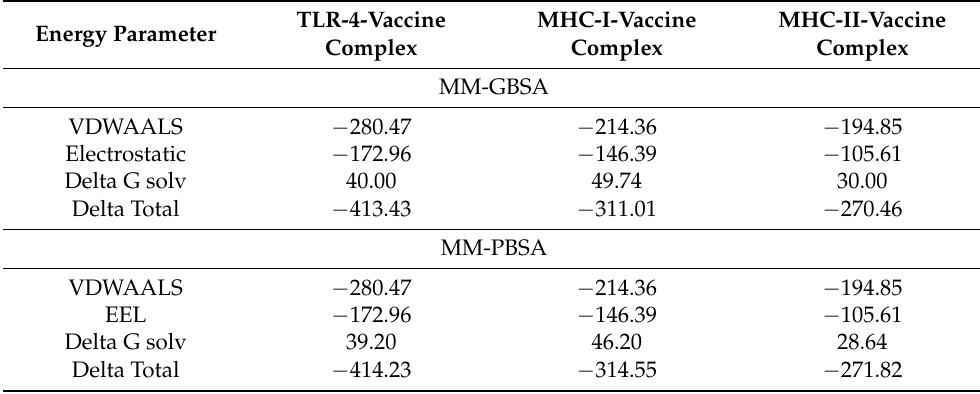
Table 14. Binding free energies shown in